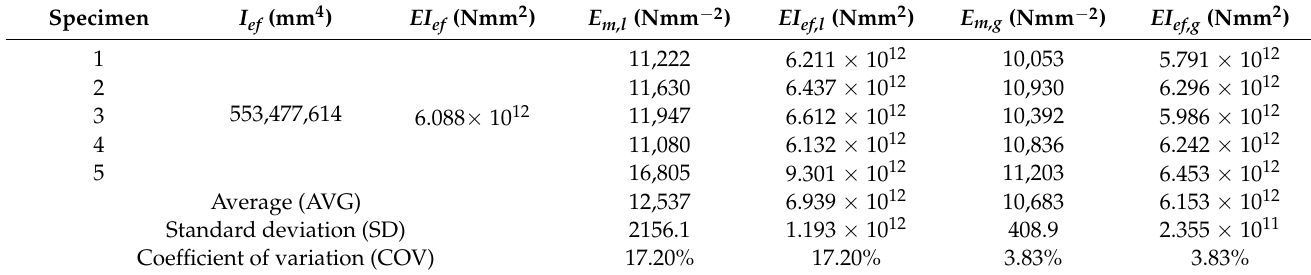
Table 6. Results of the effective moment of inertia, the moduli of elasticity and the stiffnesses in bending for CLT 240-7-2.